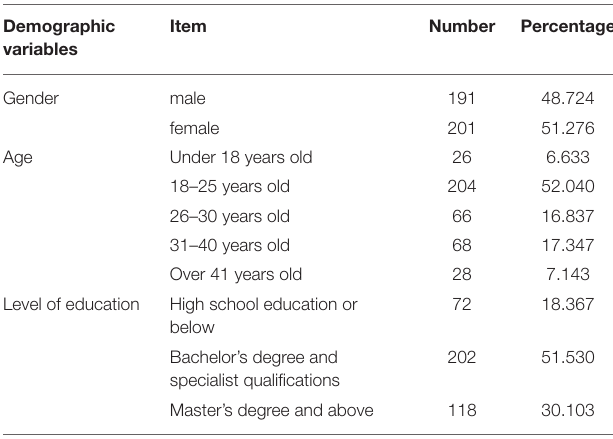
TABLE 2 | Demographic information results.